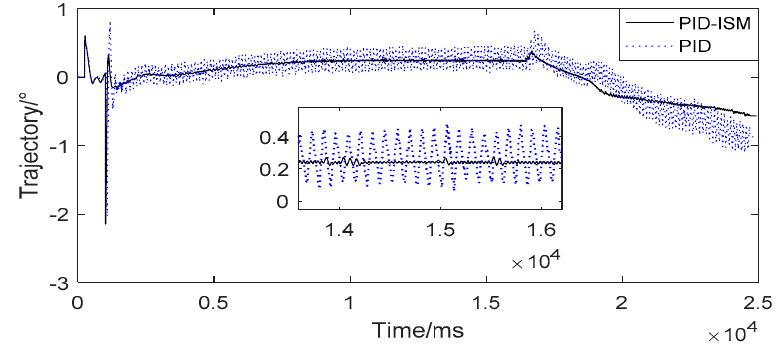
Figure 9. The limit cycle oscillation of missile trajectory.